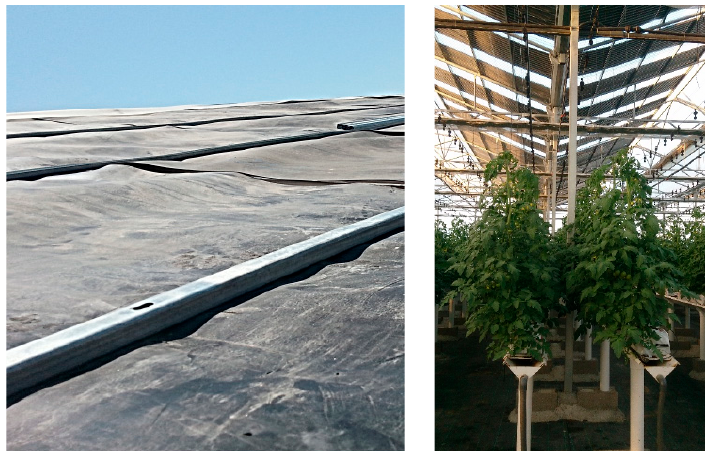
Figure 2. (Left) Roof-top installation of opaque polyethylene sheets in the greenhouse outside face in the 50% shade treatment. (Right) The inside view of the 30% shade treatment in the greenhouse.